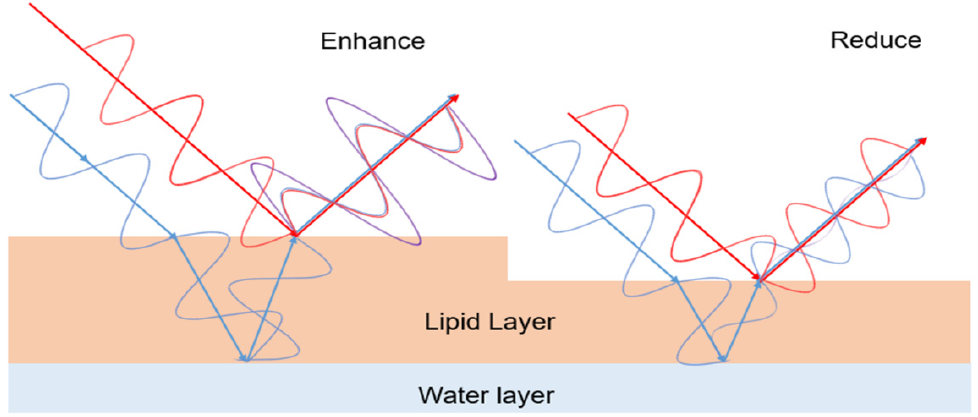
Figure 2. Interferometry is now an established technique for clinical evaluation of tear lipid layer kinetics and tear break-up. Left. The light intensity is enhanced when the phase of light reflected at the surface of the lipid layer matches the phase of light reflected at the interface between the lipid layer, of a certain thickness, and the water layer. Right. The light is reduced when the lipid layer is changed to a thickness such that the phase of the two reflected lights is shifted.